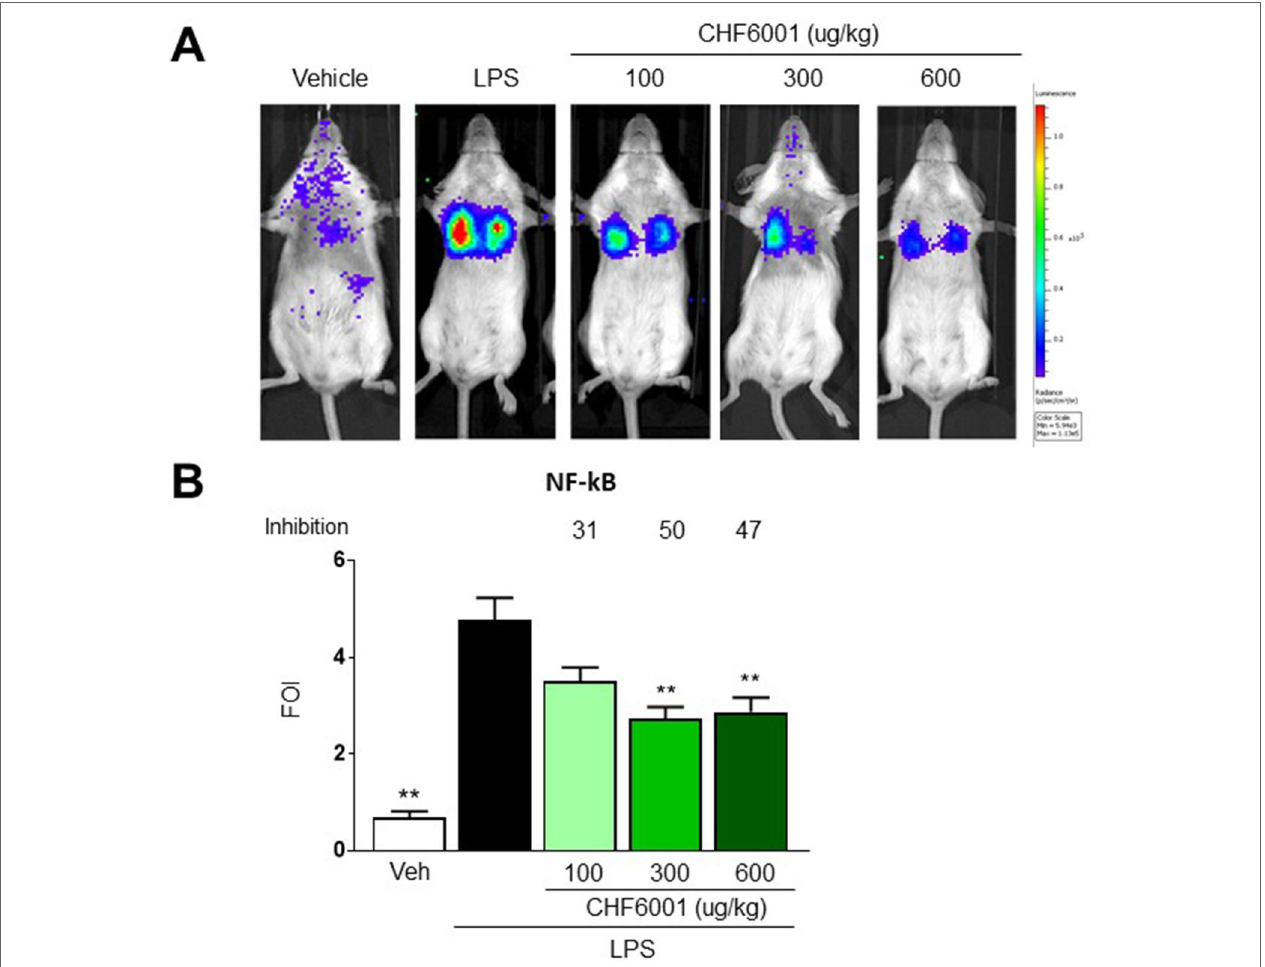
FIGURE 3 | Effects of CHF6001 on NF-kB activation in vivo as assessed by bioluminescence imaging (BLI). (A) Transient NF-kB-luc transgenic mice were pretreated with saline or CHF6001 (100–600 µg/kg by inhalation) 1 h before lipopolysaccharide (LPS) intratracheal instillation. Representative mice are shown for saline, LPS, LPS+CHF6001 (100 µg/kg), and LPS+CHF6001 (600 µg/kg). (B) Quantification of NF-kB activation by BLI, 4 h after LPS intratracheal instillation. Values are shown as the mean ± SEM, n = 6, and percent inhibition versus LPS group is reported. ** P < 0.01 versus LPS group (Dunnett’s